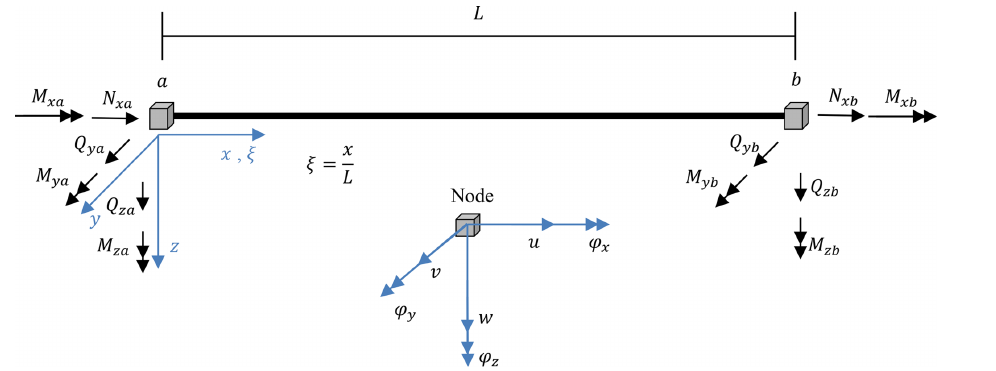
kinetic field matrix. In the last step of the integration, using both field matrices, the respective element stiffness and the element mass matrices can be calculated using simple matrix